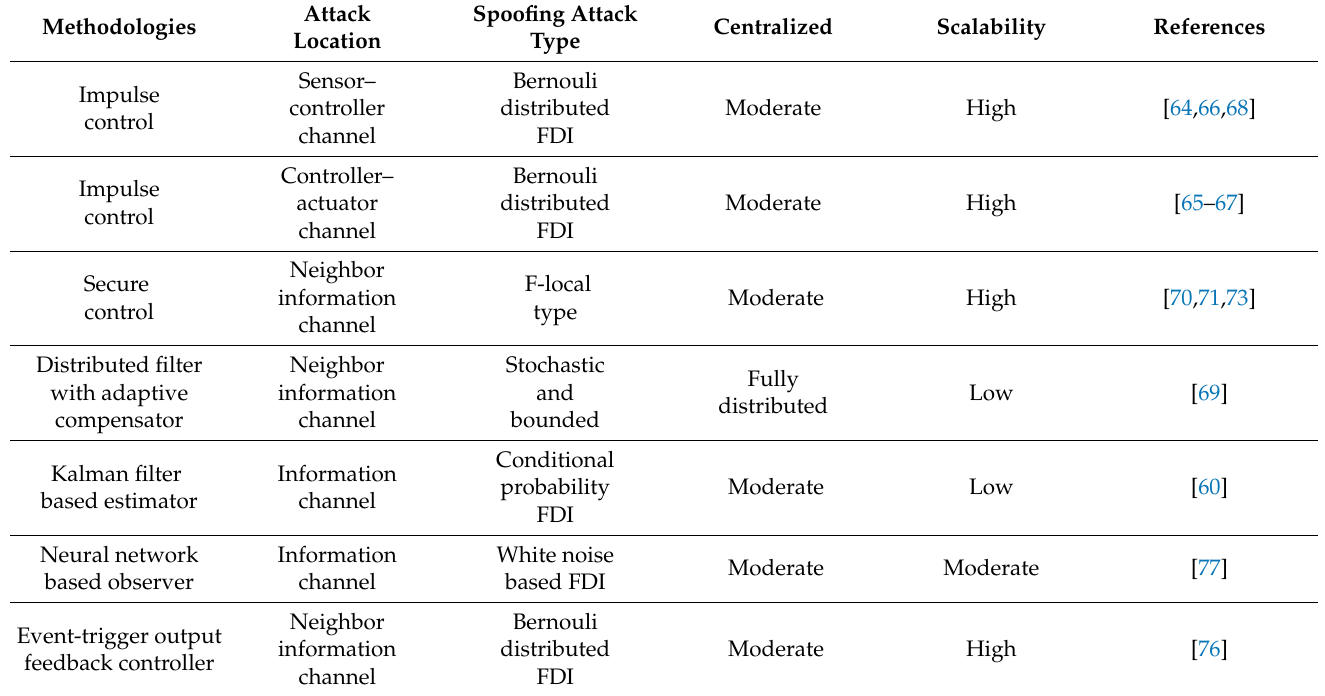
Table 3. Recent Work on Spoofing